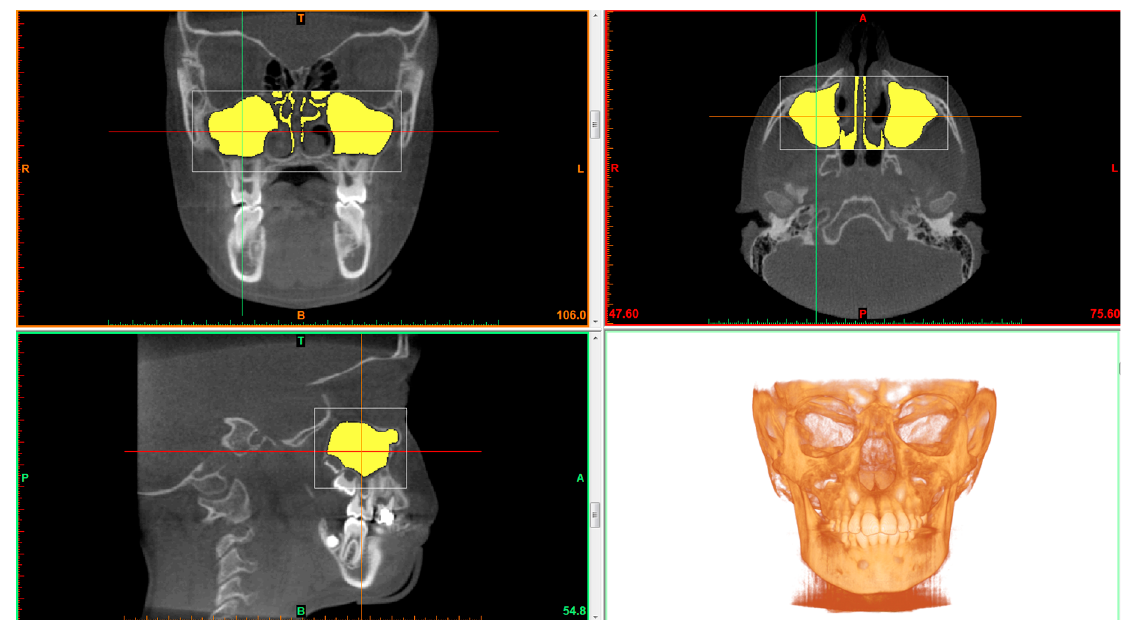
Figure 2. Sagittal, coronal and axial view of the maxillary sinus. The isolated maxillary sinuses are clearly visible.